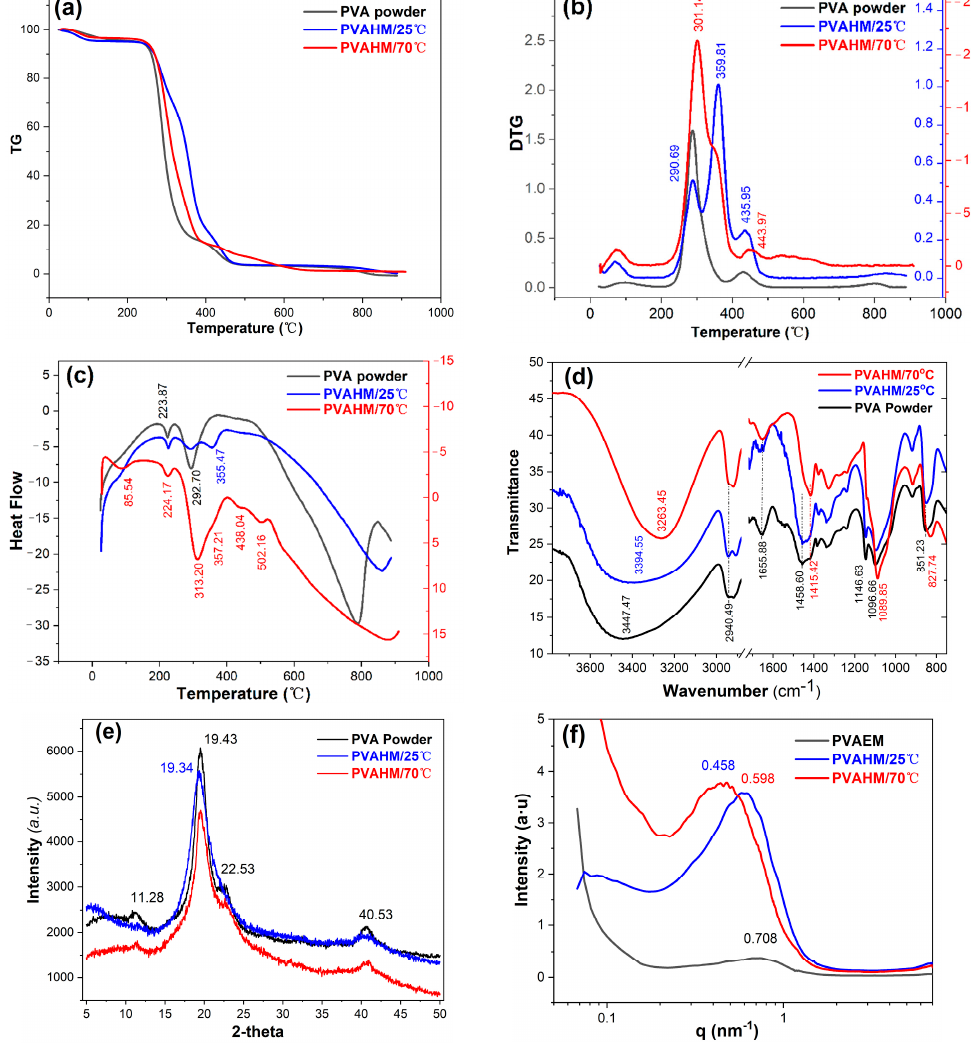
Figure 3. ( a – c ) TG, DTG, and DSC thermograms; ( d ) FTIR spectra; ( e ) XRD diffractograms of pure PVA powder, PVAHM/25 °C, and PVAHM/70 °C; and ( f ) SAXS patterns of PVAEM, PVAHM/25 °C, and PVAHM/70